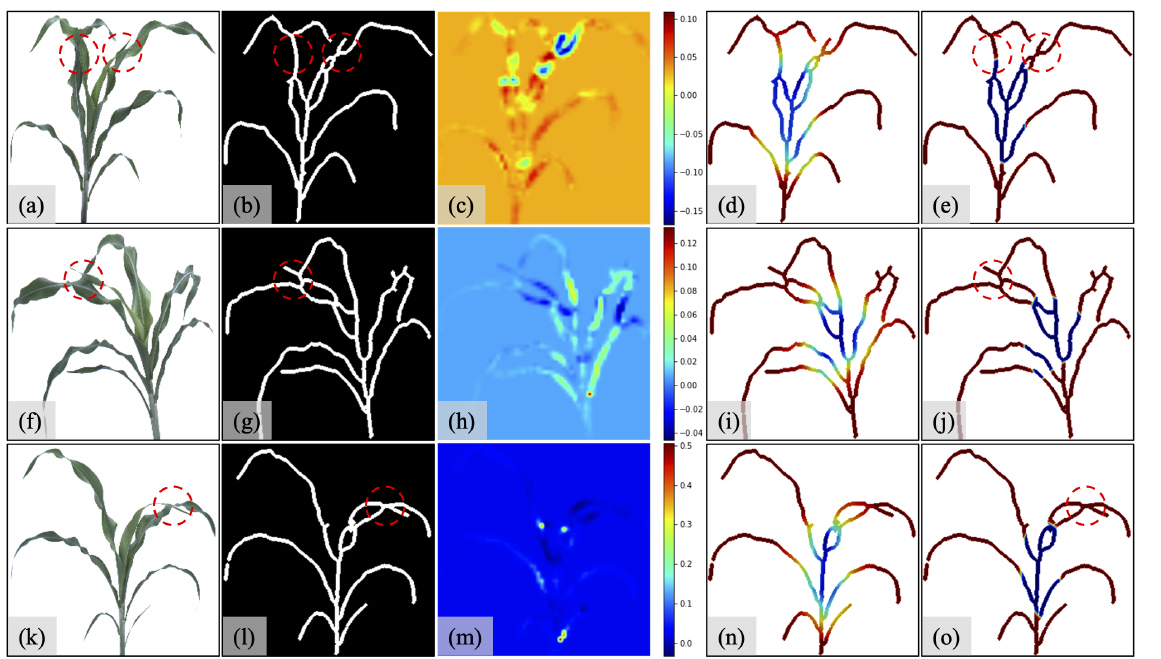
Figure 11. Qualitative evaluations on datasets S2. The first row shows the qualitative analysis of dataset S2S, the second row shows the qualitative analysis of dataset S2S_6A, and the third row shows the qualitative analysis of dataset S2S_12A. In each row, the first column ( a , f , k ) shows original sorghum images, the second column ( b , g , l ) shows skeleton structure images corresponding to the first column, the third column ( c , h , m ) shows heatmaps from input modification method for second column images as input, fourth column ( d , i , n ) shows heatmaps from Grad-CAM for second column images as input. The fifth column ( e , j , o ) shows emphasized heatmaps from Grad-CAM for second-column images as